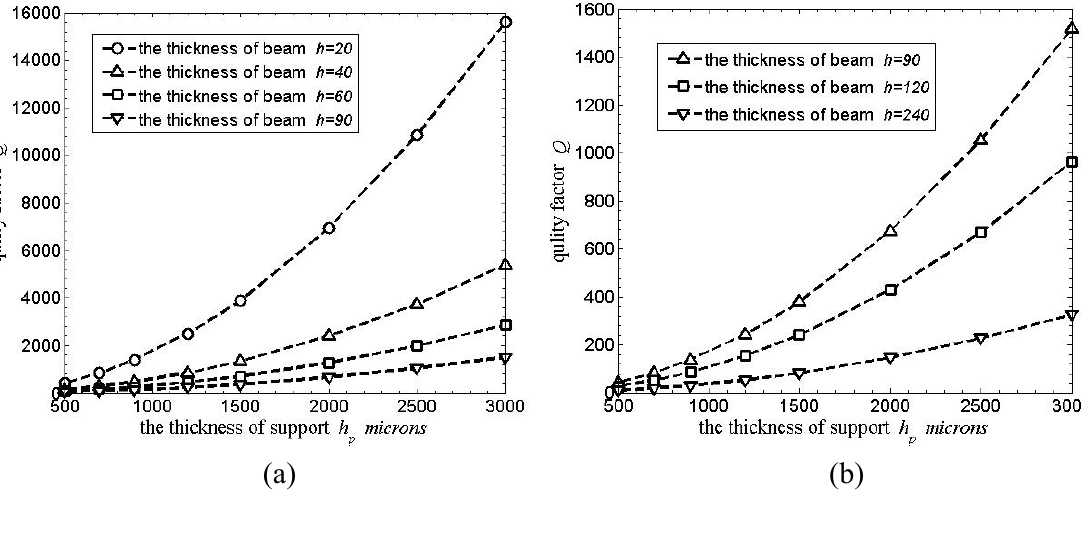
Figure 5. Support loss for rocking mass gyroscope. (a) Q factor dependent on h (b) Q factor dependent on h